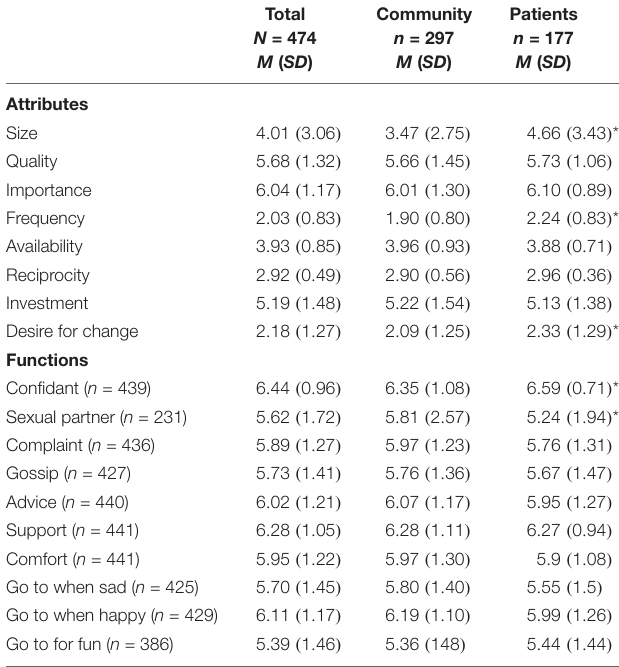
TABLE 3 | Means and standard deviations of the FAR for the community and patient Total Community Patients N = 474 n = 297 n = 177